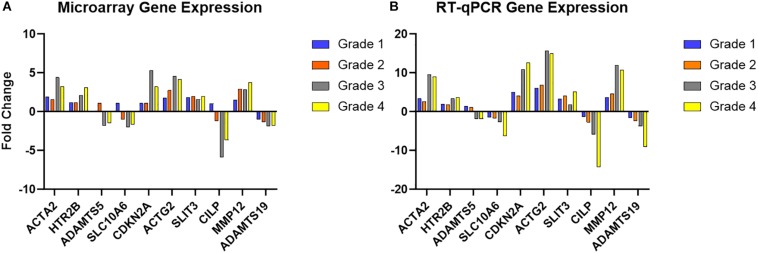
Microarray validation with RT-qPCR for selected genes. (A) Microarray fold change in gene expression intensity for each grade of disease, compared to normal. (B) RT-qPCR fold change (normalized to GAPDH, MRPS25, and RPL32) in each grade of disease compared to normal. Full data set are shown in Supplementary Table S2.